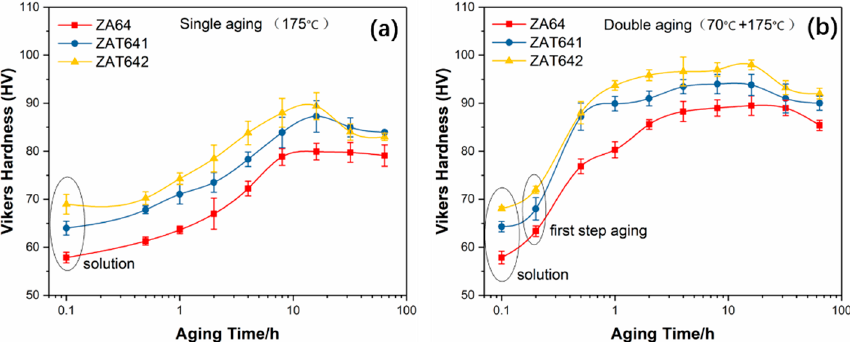
Figure 9. Aging-hardening curves of the Mg-6Zn-4Al- x Sn alloys: ( a ) single aging, and ( b ) double aging.